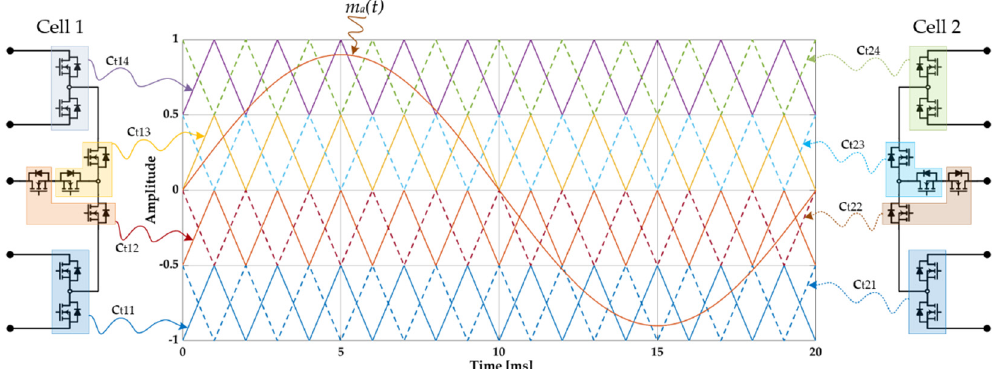
Figure 6. Modulation control scheme for power semiconductors located in a single-phase of the inverter.